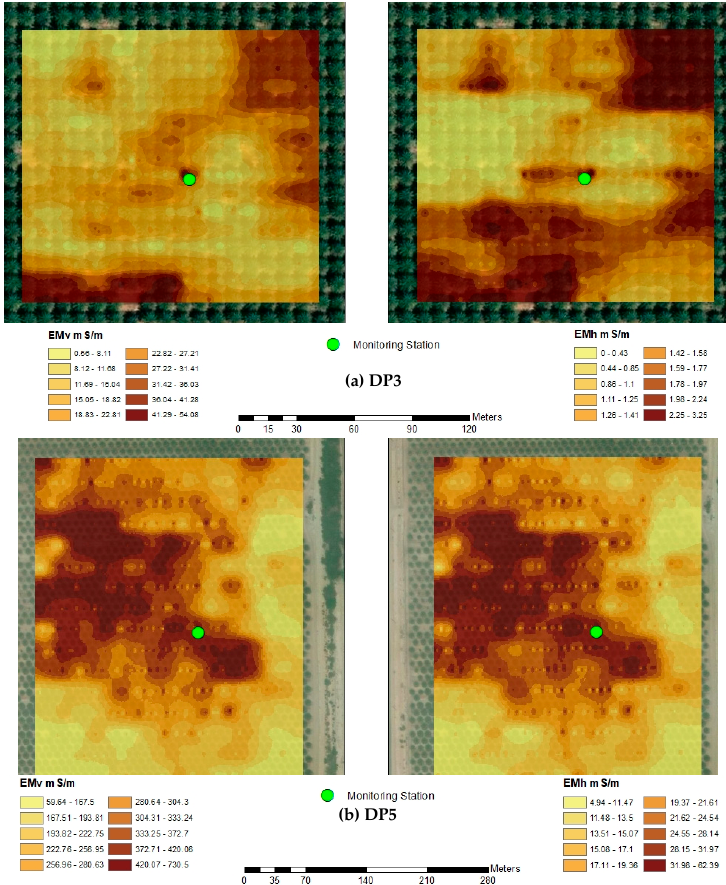
Figure 4. Spatial distribution of ancillary variables EM h (electromagnetic induction measurement in the horizontal coil orientation) and EM v (electromagnetic induction measurement in the vertical coil orientation) at the ( a ) DP3 and ( b ) DP5 experimental sites. 100 m S m − 1 is equal 1 dS m − 1 .